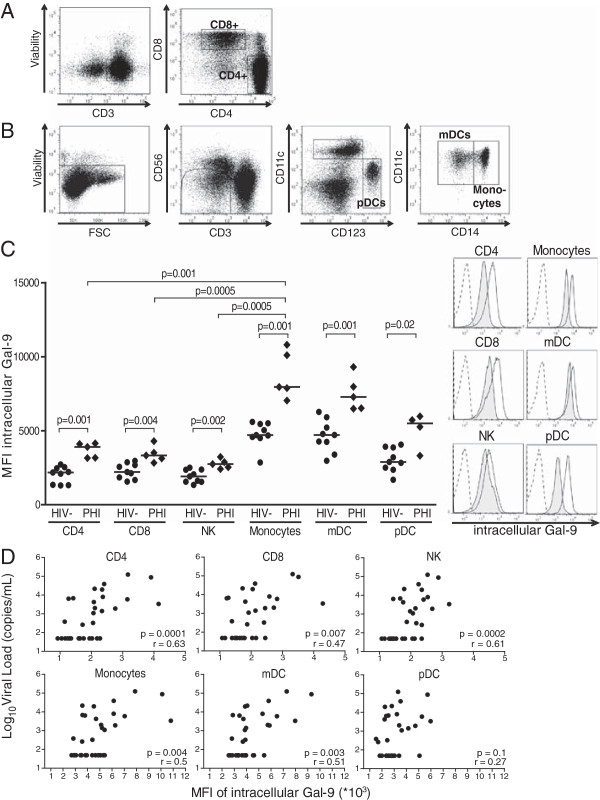
Expression of galectin-9 in PBMCs is increased in early HIV-1 infection and correlates with HIV-1 viremia. Flow cytometry gating strategy to analyze intracellular expression of Gal-9 on (A) CD4+ and CD8+ T cells and (B) pDCs, monocytes or mDCs. Gates are set to exclude dead cells (viability marker+), and expression of Gal-9 on various lymphocyte subsets is defined by using appropriate fluorescence-minus-one controls. (C) Dot plots display the MFI of intracellular Gal-9 in the indicated immune cell subsets from 9 healthy (HIV-) and 5 untreated subjects with early infection as determined by flow cytometry. Horizontal lines indicate the median percentages. Differences where p < 0.05 are indicated. Histogram overlays display representative examples of intracellular Gal-9 expression in each lymphocyte subset analyzed in healthy controls (tinted) and in individuals with early HIV-1 infection (transparent) compared to the FMO (dotted line). PHI, early HIV-1 infection (D) Correlations between the logarithmic viral load and the MFI of intracellular Gal-9 in CD4 + T cells, CD8+ T cells, NK cells, monocytes, mDCS and pDCs from a subset of 32 HIV-1-positive individuals, including 4 subjects with early infection, 6 viremic controllers, 6 elite controllers, 9 subjects with chronic untreated, and 7 with chronic treated HIV-1 infection.